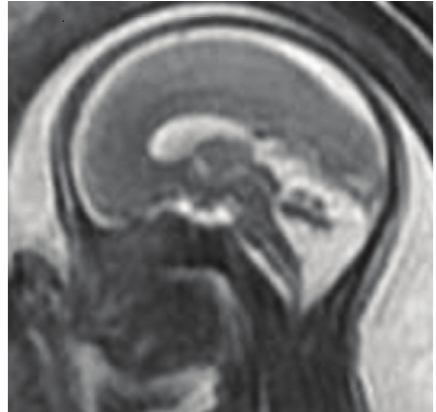
Figure 2: Second trimester fetal RMN (sagittal T2 weighted image), showing the posterior cranial fossa with the complete vermis. Persistent Blake pouch cyst was